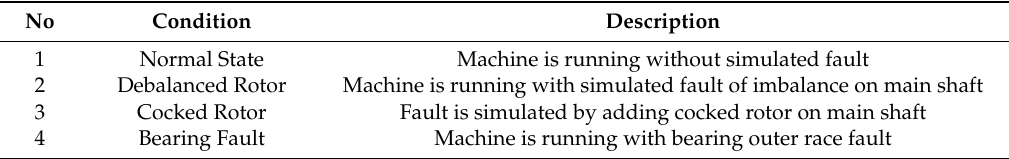
Table 1. Simulated fault conditions.